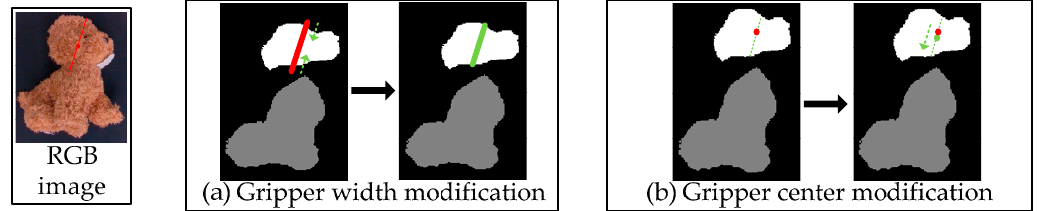
Figure 7. Grasp pose modification of ( a ) the gripper width and ( b ) the gripper center.